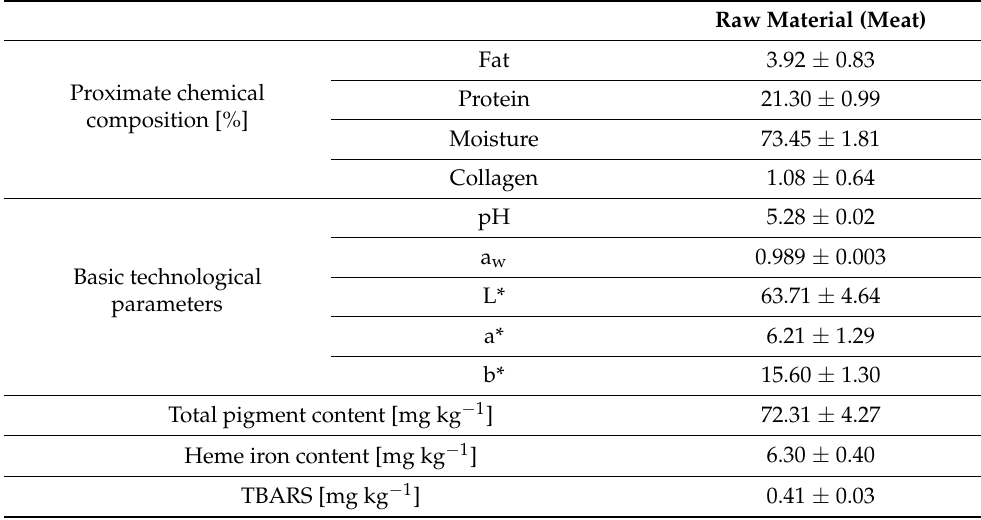
Table 2. Proximate chemical composition and basic technological parameters characterizing the raw materials (mean ± standard deviation).